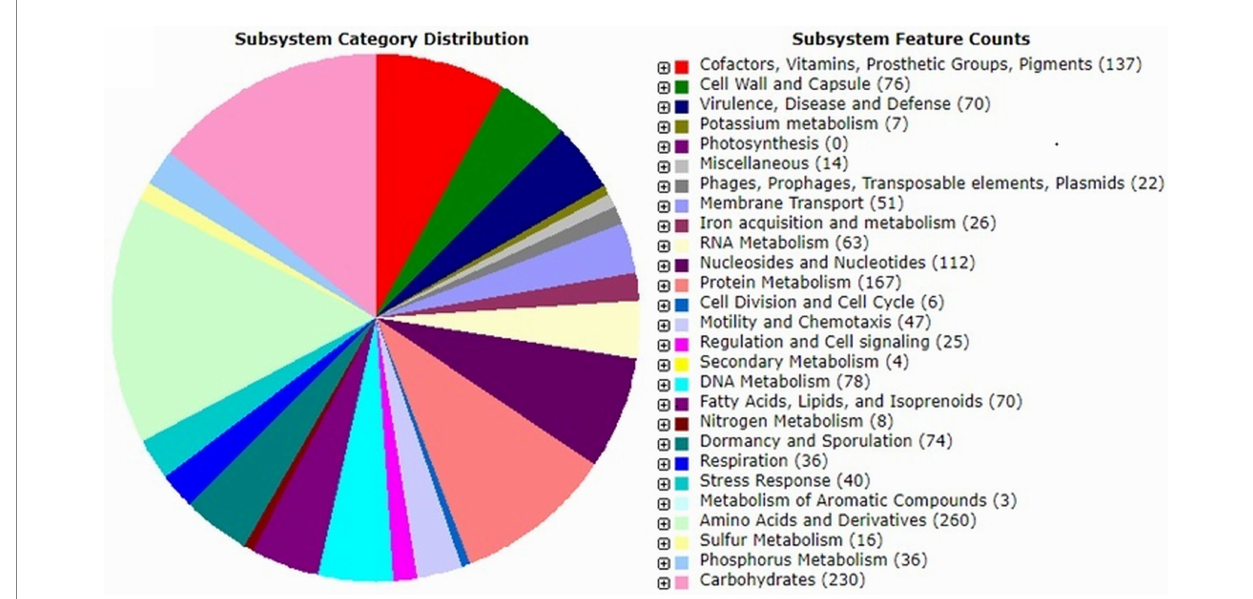
FIGURE 2 Paenibacillus antarcticus strain IPAC21 subsystem features based on the RAST annotation